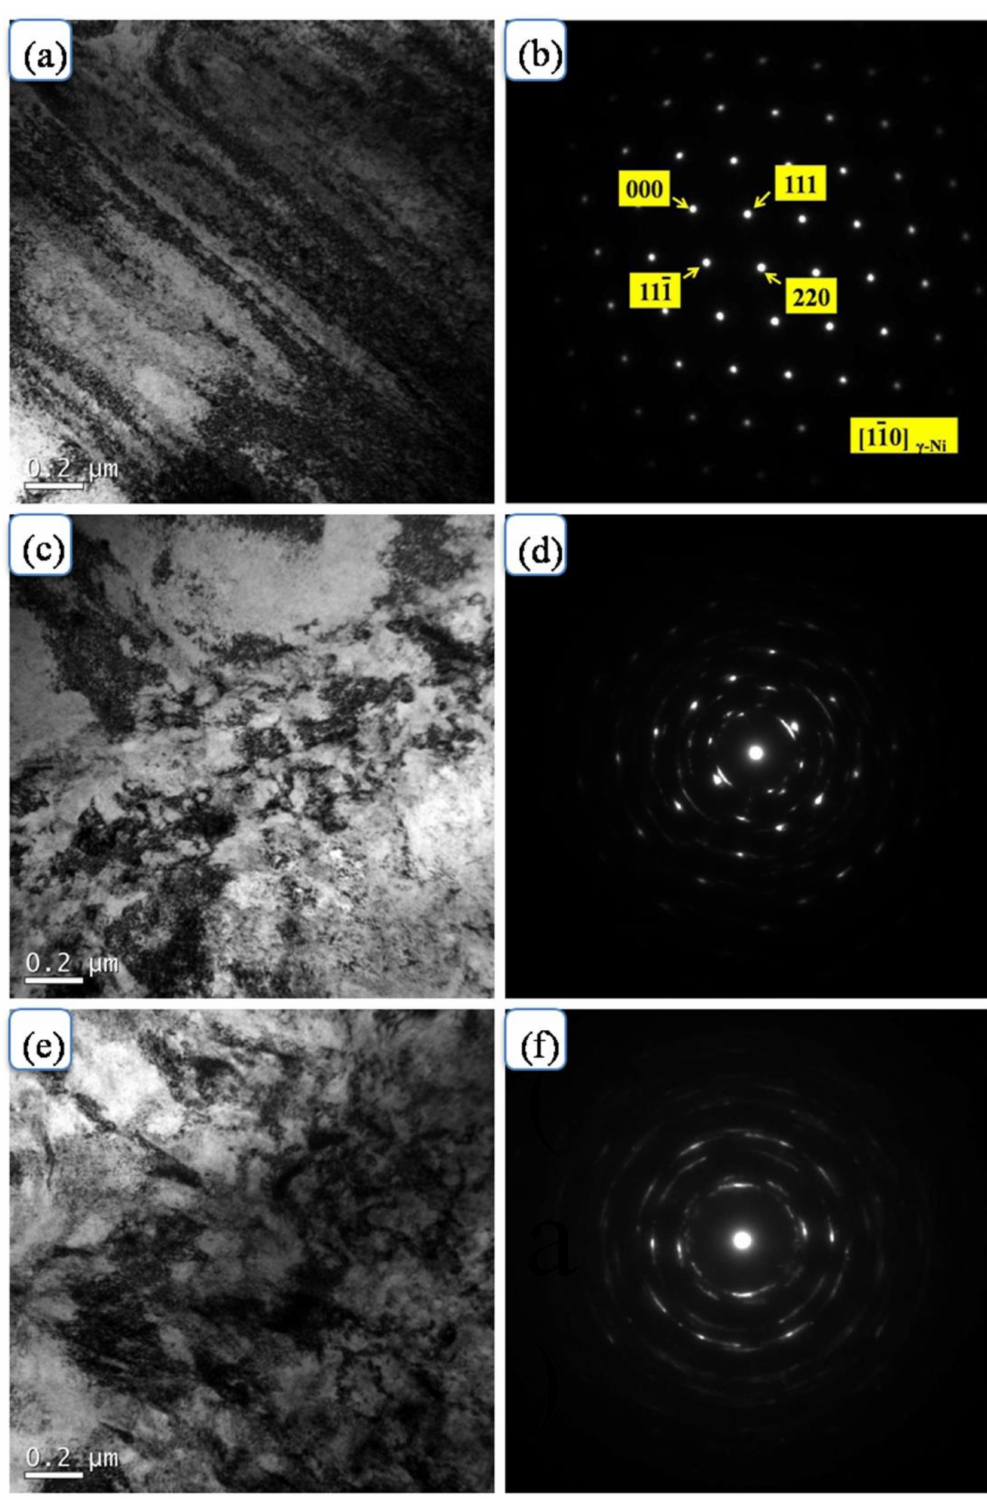
Figure 10. TEM micrographs of as-cast Ni-Nb5 alloy undergoing compressive deformation degree by 60%: ( a ) Bright field image indicating high-density dislocations; ( b ) Diffraction pattern of ( a ); ( c ) Bright field image indicating refined grains; ( d ) Diffraction pattern of ( c ); ( e ) Bright field image indicating occurrence of nanocrystalline grains; ( f ) Diffraction pattern of ( e